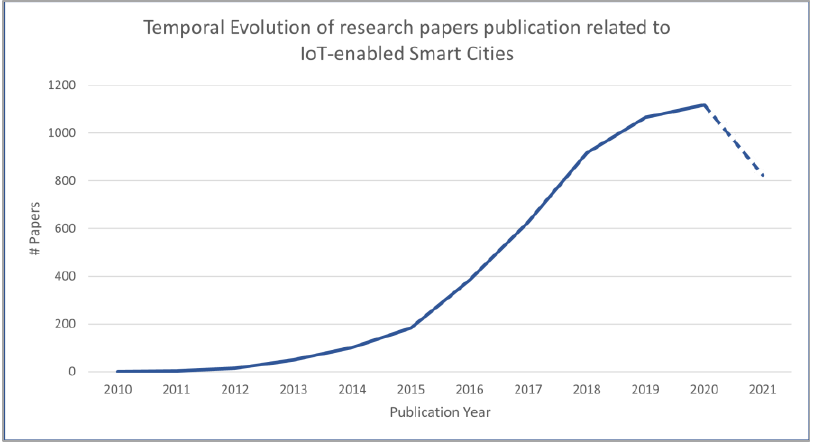
Figure 2. The temporal evolution of research papers related to IoT-enabled smart cities, as retrieved from the WoS database (collected in October 2021).